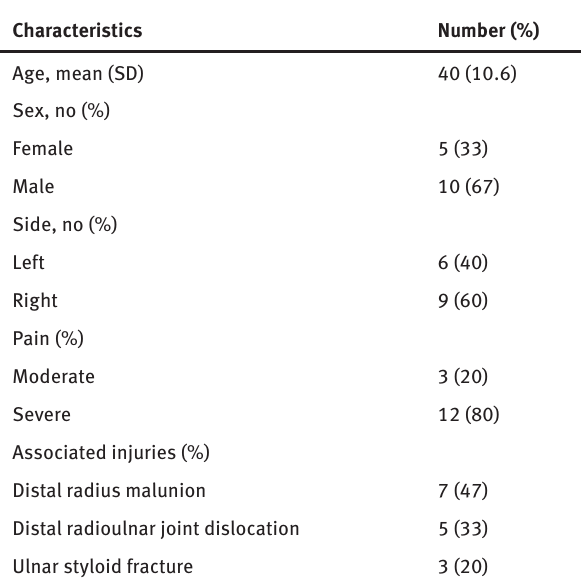
Table 2: The clinical characteristics of 15 patients (15 wrist).